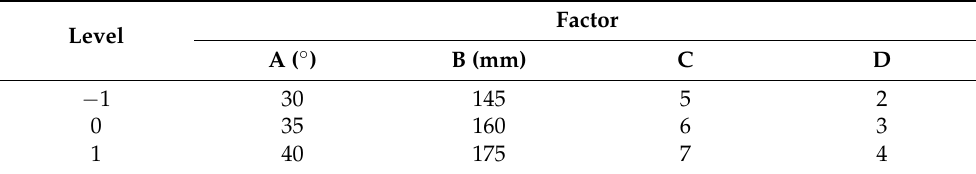
Table 4. Test scheme factors and levels of structural parameters.